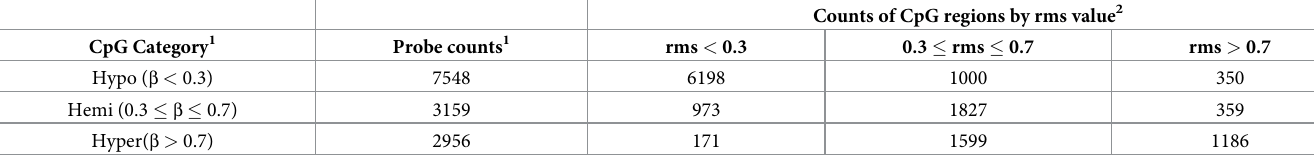
Table 3. Counts of Illumina human MethylationEPIC probes by β -value and concordance with MBD-seq at corresponding CpG